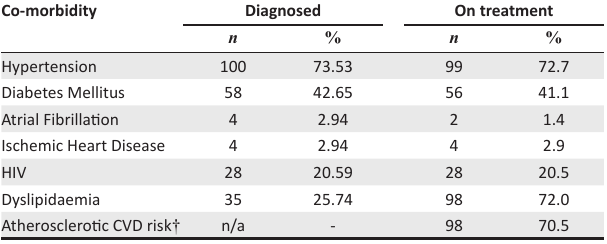
TABLE 3: Co-morbidities and